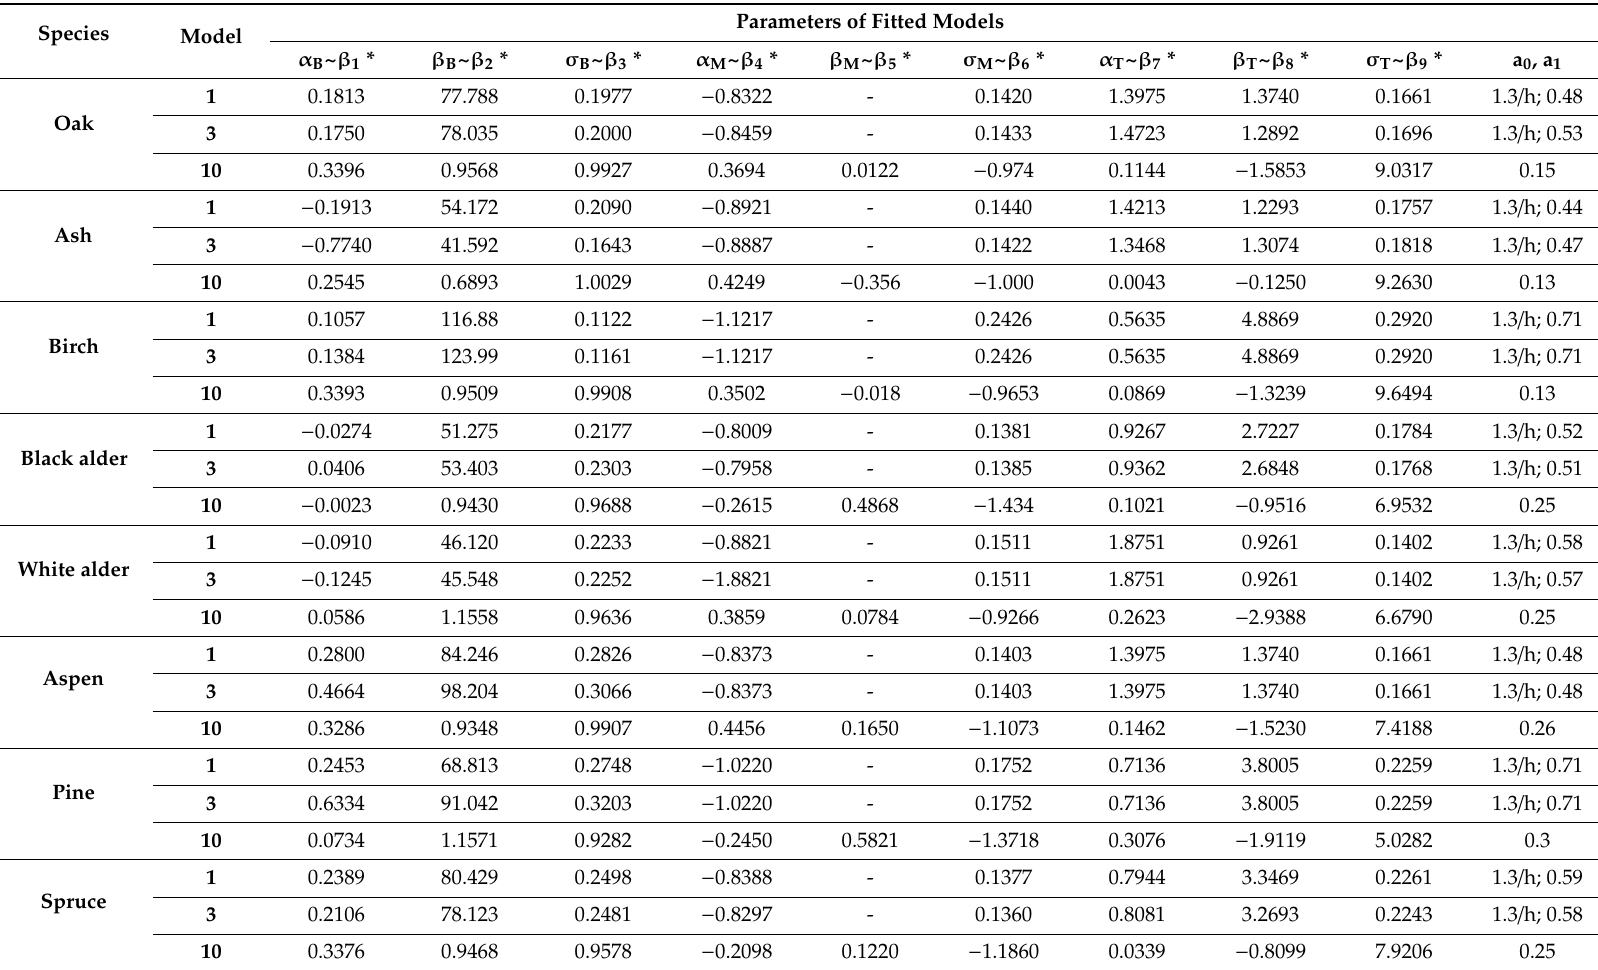
Table 4. Estimates of the fixed e ff ect parameters for all fitted stem taper